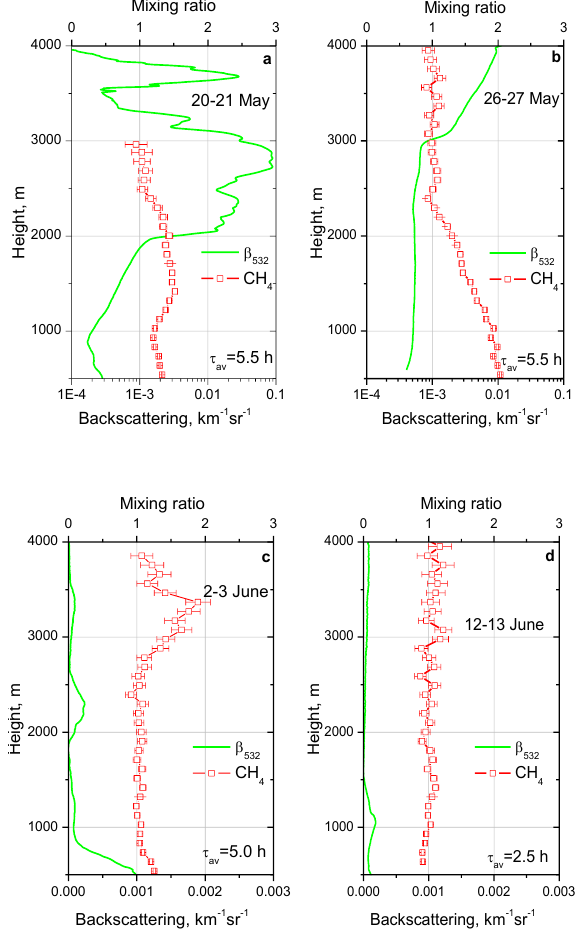
Figure 2. Vertical profiles of the methane mixing ratio and aerosol backscattering at 532 nm for four night measurement sessions. Mixing ratios are not calibrated and the value 1.0 corresponds to approximately 2 ppm. Signals averaging time  av is given in